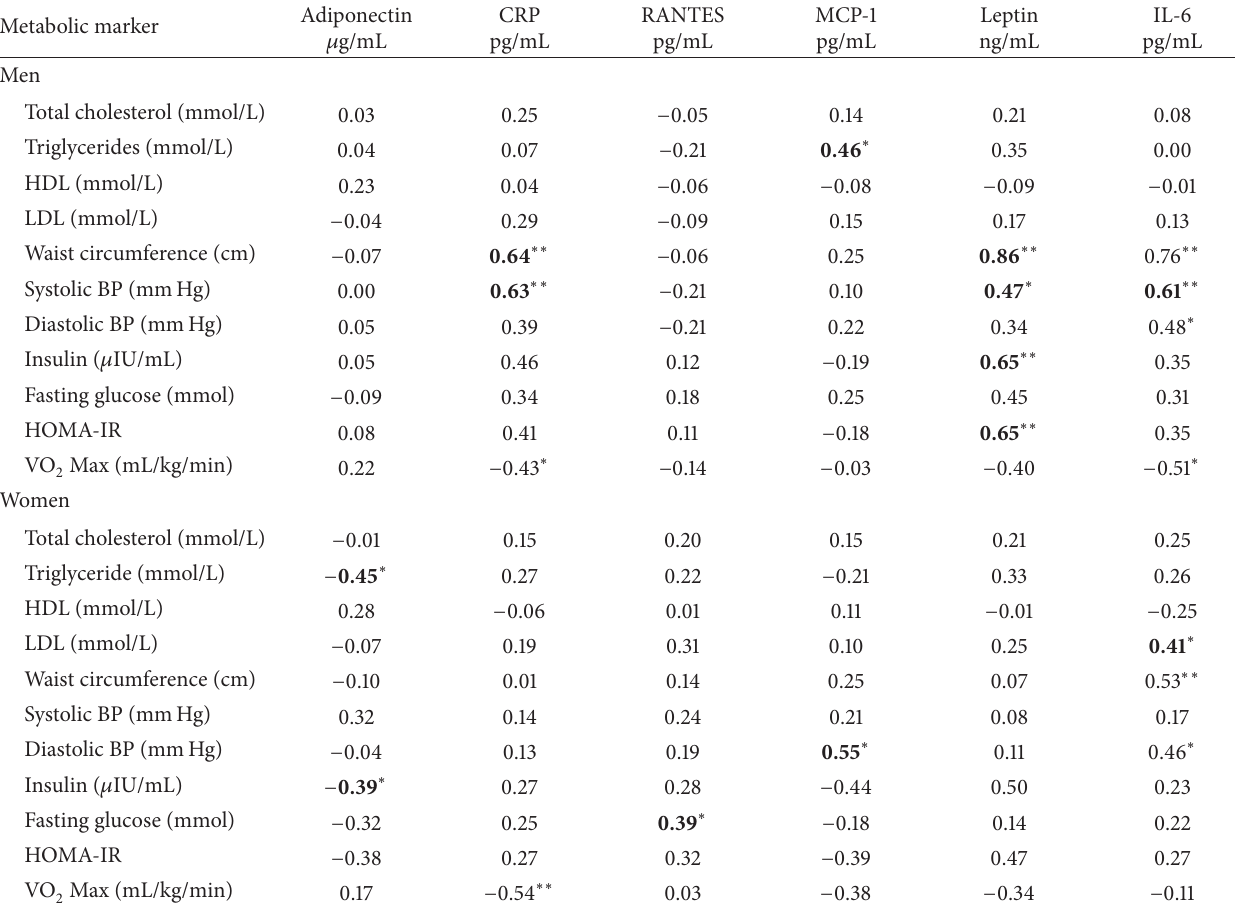
Table 3: Correlation between metabolic markers, and serum adipokines and inflammatory markers in men and women. Adiponectin CRP Metabolic marker 𝜇 g/mL Men Total cholesterol (mmol/L)